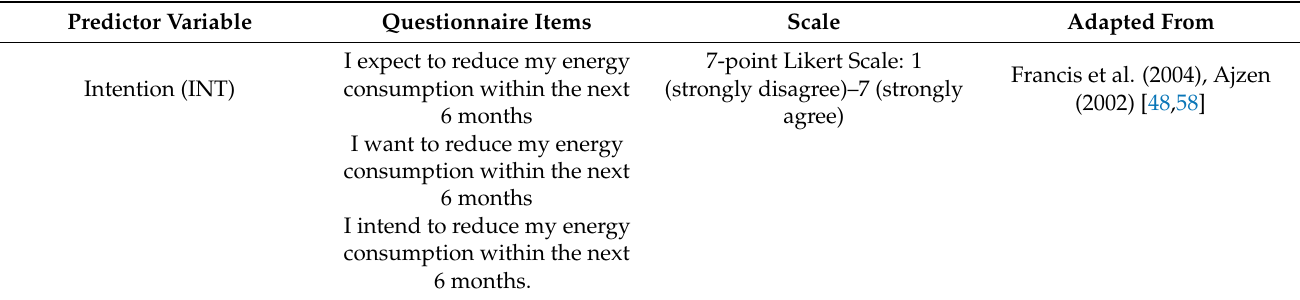
Table 1. Intention (the table was created by using resource of Ajzen and Fishbein, 2005) [51] . Predictor Variable Questionnaire Items Scale Adapted